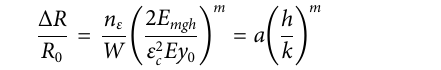
Frontiers in Materials |